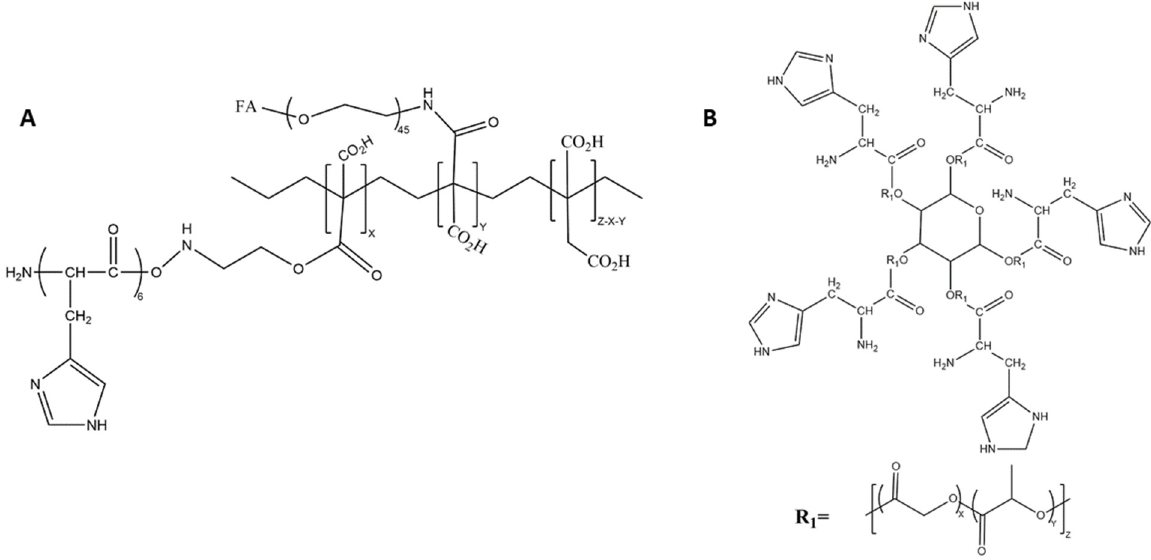
Figure 6. Chemical structure of the ( A ) graft polymer PIA–g-PEG–FA–g-PLH, and ( B ) the five-armed star-shaped branched PLGA copolymers in which a single histidine was coupled to the end of each arm.